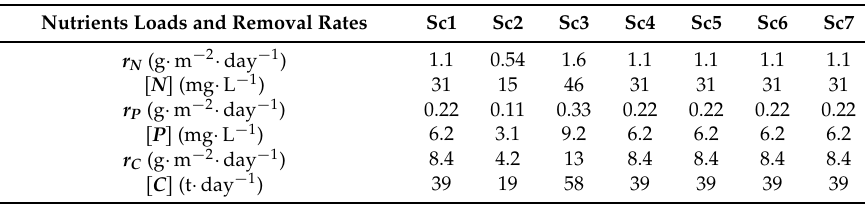
Table 3. Average removal rates of nitrogen, phosphorus and carbon and minimum concentrations required for microalgal cultivation in each of the studied scenarios